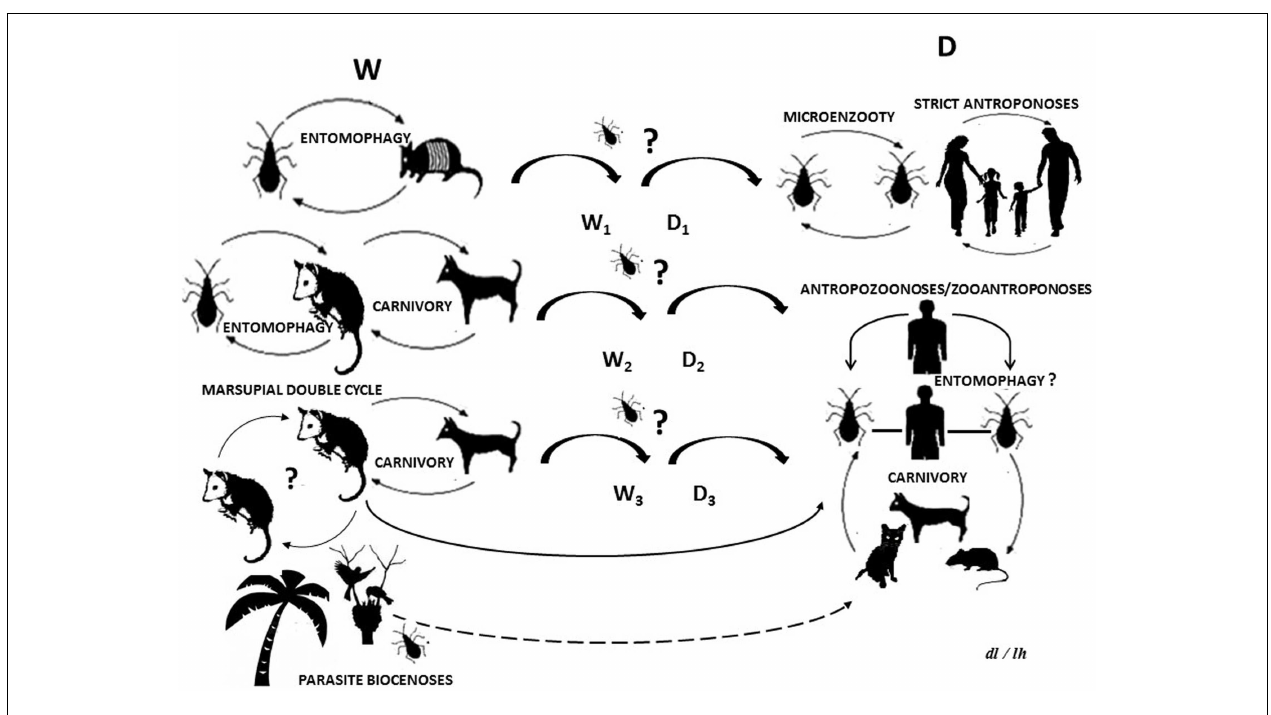
anthroponosis, or micro-enzooty. (W n )Wild sub-cycles (D n ) domestic sub-cycles. Question marks indicate uncertainty as regards parasite circulation patterns or processes.The dotted line indicates a hypothetical